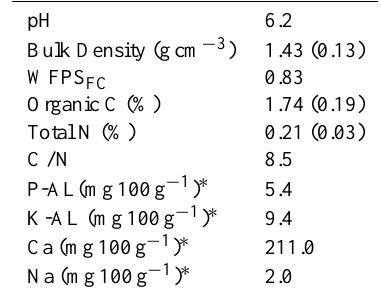
Table 1. Chemical and physical properties of the top soil at Østrevoll defined as naturally poorly drained silty clay loam. Stan- dard deviations in parentheses where available. WFPS FC =water- filled pore space at field